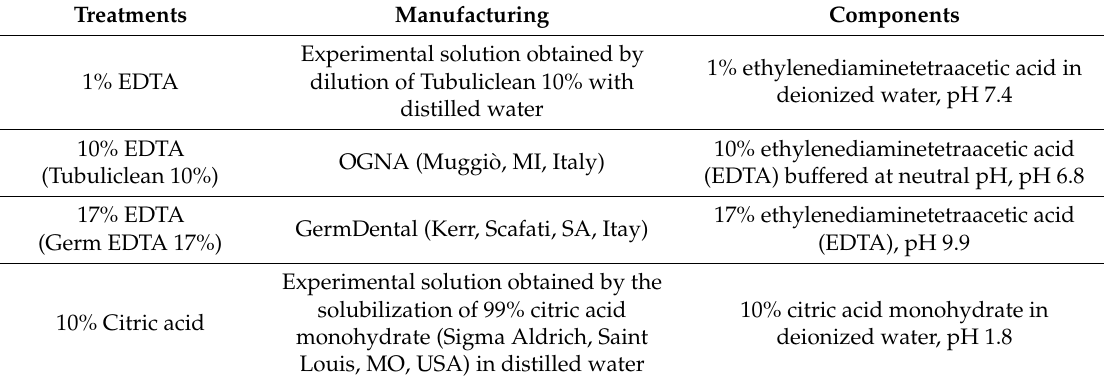
Table 1. Tested chelating